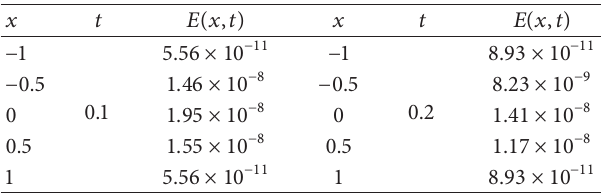
Table 1: Absolute errors for Example